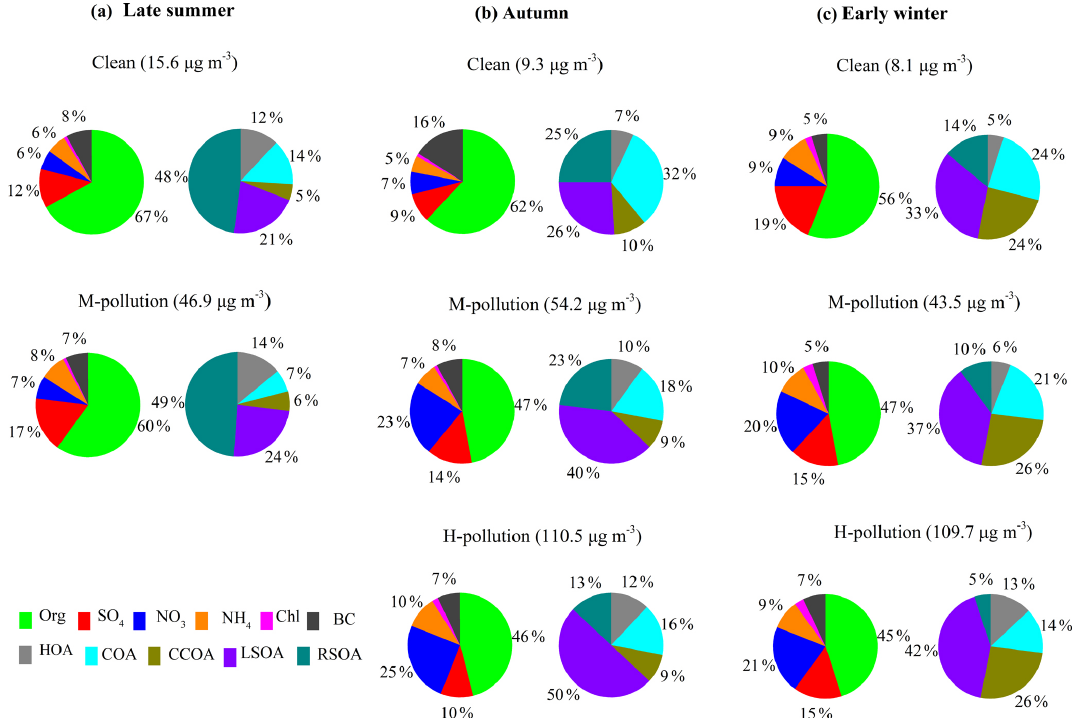
Figure 4. Relative contributions of PM 1 species and OA sources on clean days, M-pollution days and H-pollution days during late sum- mer (a) , autumn (b) and early winter (c)